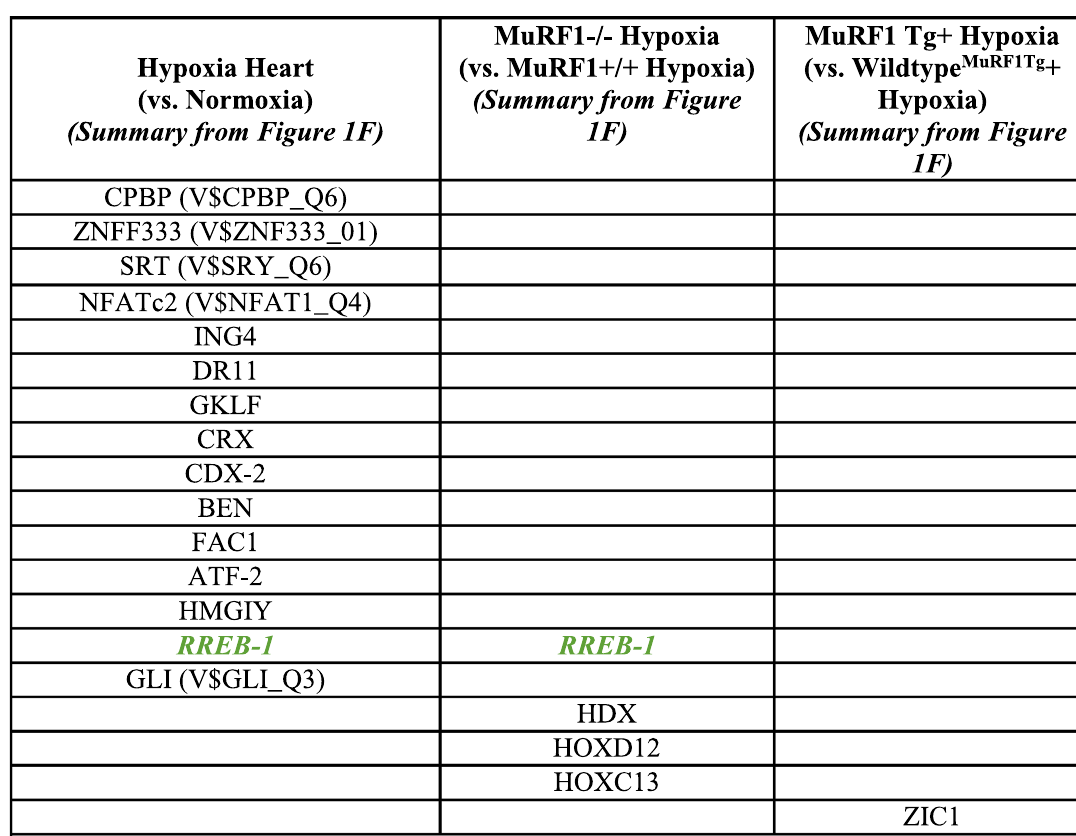
Table 2 Summary of transcription factors identified in the MuRF1-/- and MuRF1 Tg+ right ventricles (vs. wildtype) by TRANSFAC® Match Analysis. From Figure 2C (MuRF1-/-) and Figure 4C (MuRF1 Tg+) based off differentially expressed genes in Figure 2B and Figure 4B. Matching colors represent related transcription factors identified in hearts lacking MuRF1 and hearts with